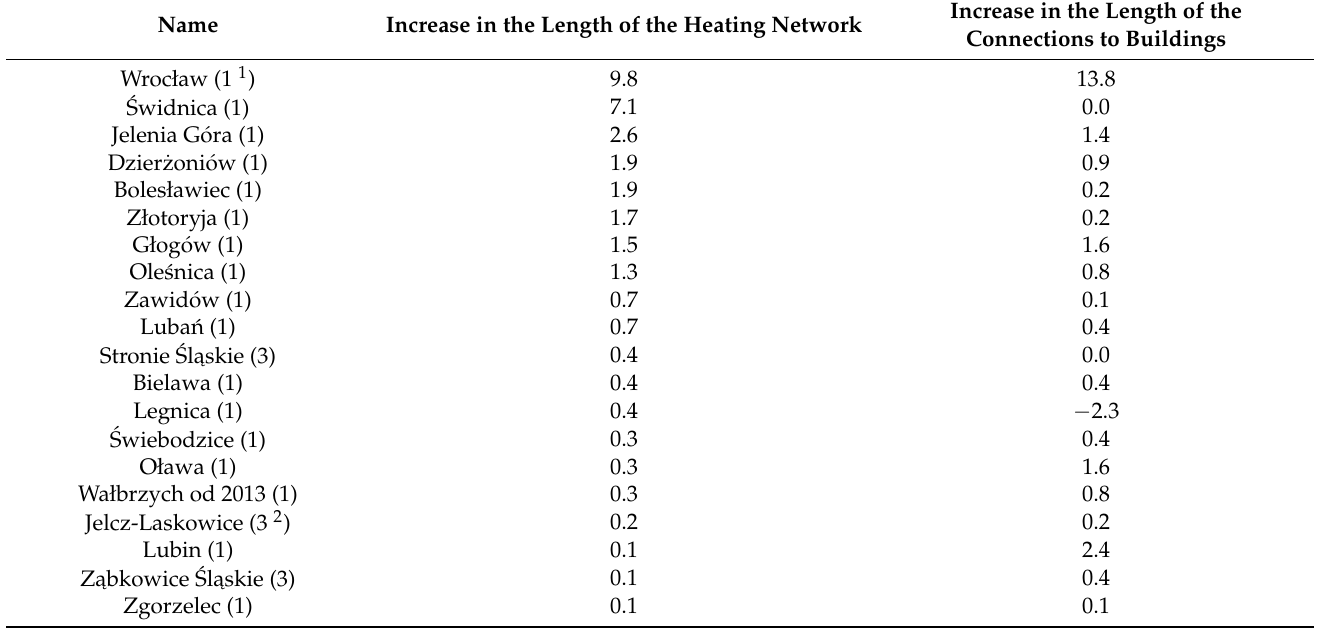
Table 15. Increase in the length of the heating network in the communes of the Dolno´sl ˛askie Voivodeship in 2017–2019